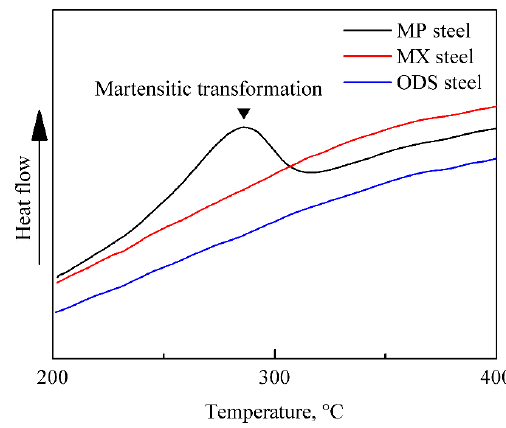
Figure 7. Differential scanning calorimeter (DSC) curves of the consolidated steels.